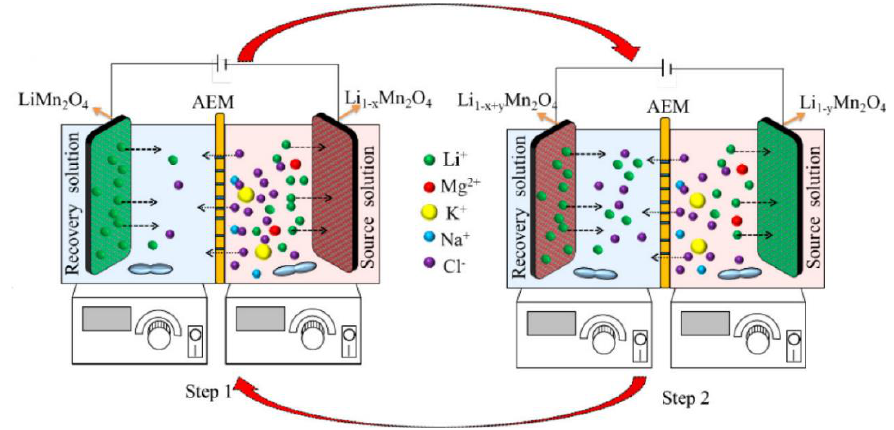
Figure 5. Schematic of lithium-extraction process. Reprinted with permission from Ref. [49]. Copy- right 2020 American Chemical Society.